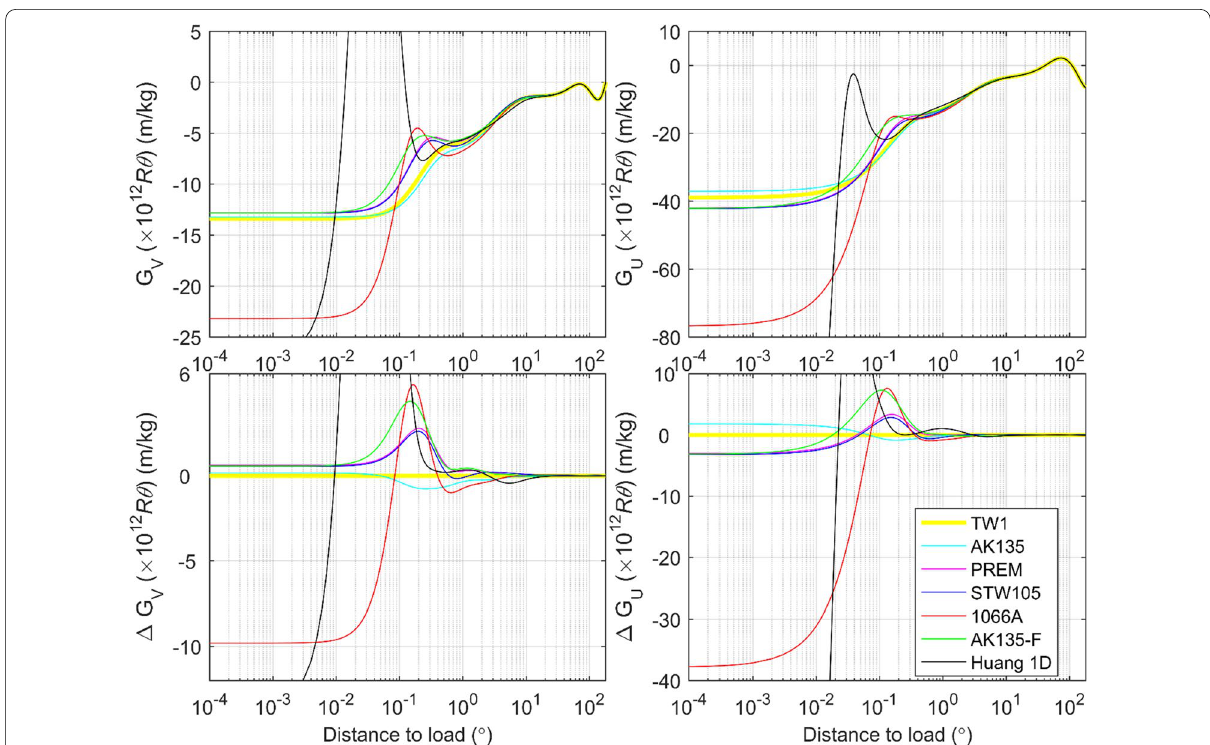
Fig. 10 Displacement Green’s functions based on the different Earth models and their corresponding differences. The displacement Green’s functions (top row) are computed from TW1 (yellow), AK135 (cyan), PREM (magenta), STW105 (blue), 1066A (red), AK135-F (green), and Huang 1D (black) and are scaled by 10 12 Rθ in the CE frame. The differences in displacement Green’s functions (bottom row) relative to TW1. The left and right columns are the horizontal and vertical components, respectively